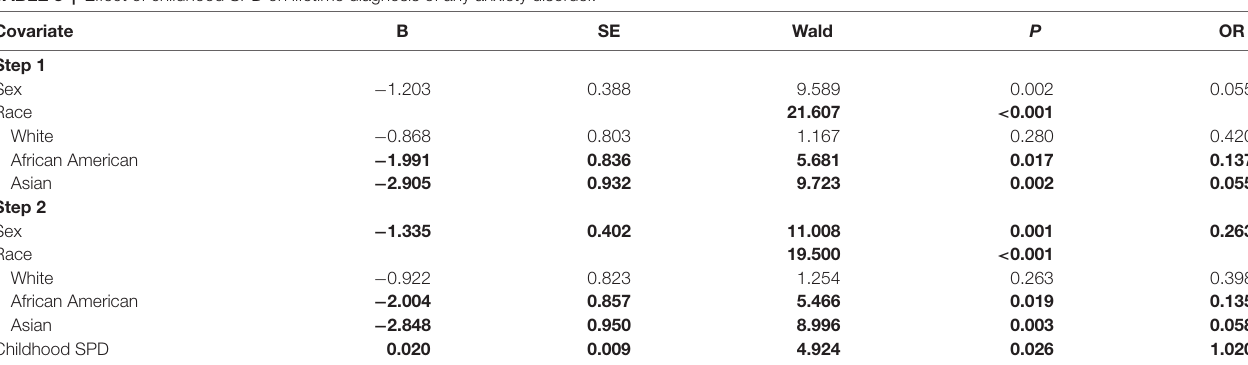
TABLE 3 | Effect of childhood SPD on lifetime diagnosis of any anxiety disorder. Covariate B SE Wald